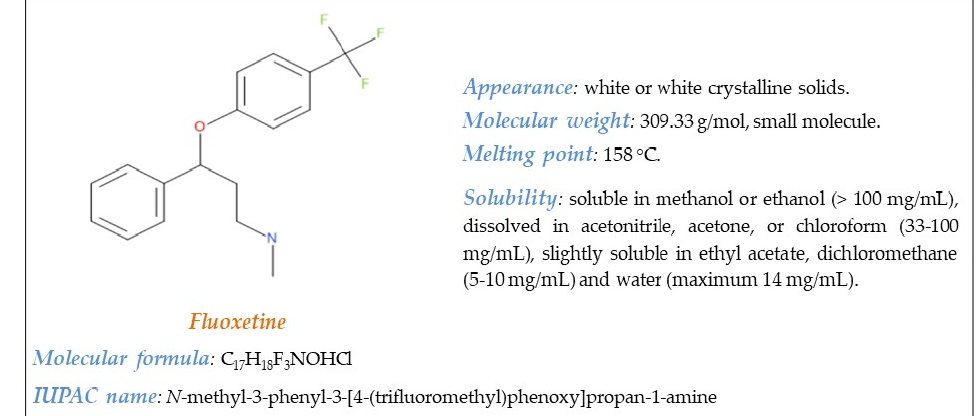
Figure 1. Physical and chemical properties of fluoxetine.